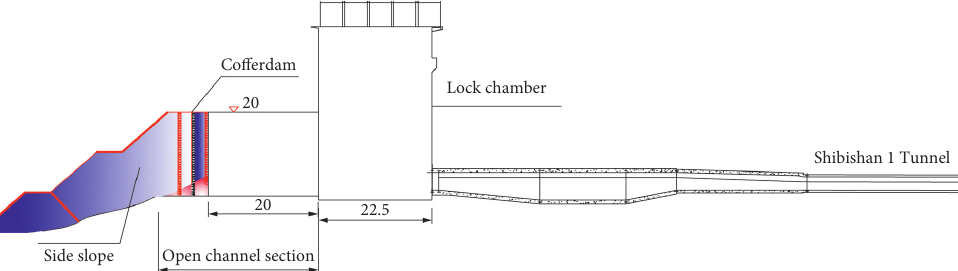
Figure 1: Project site map.